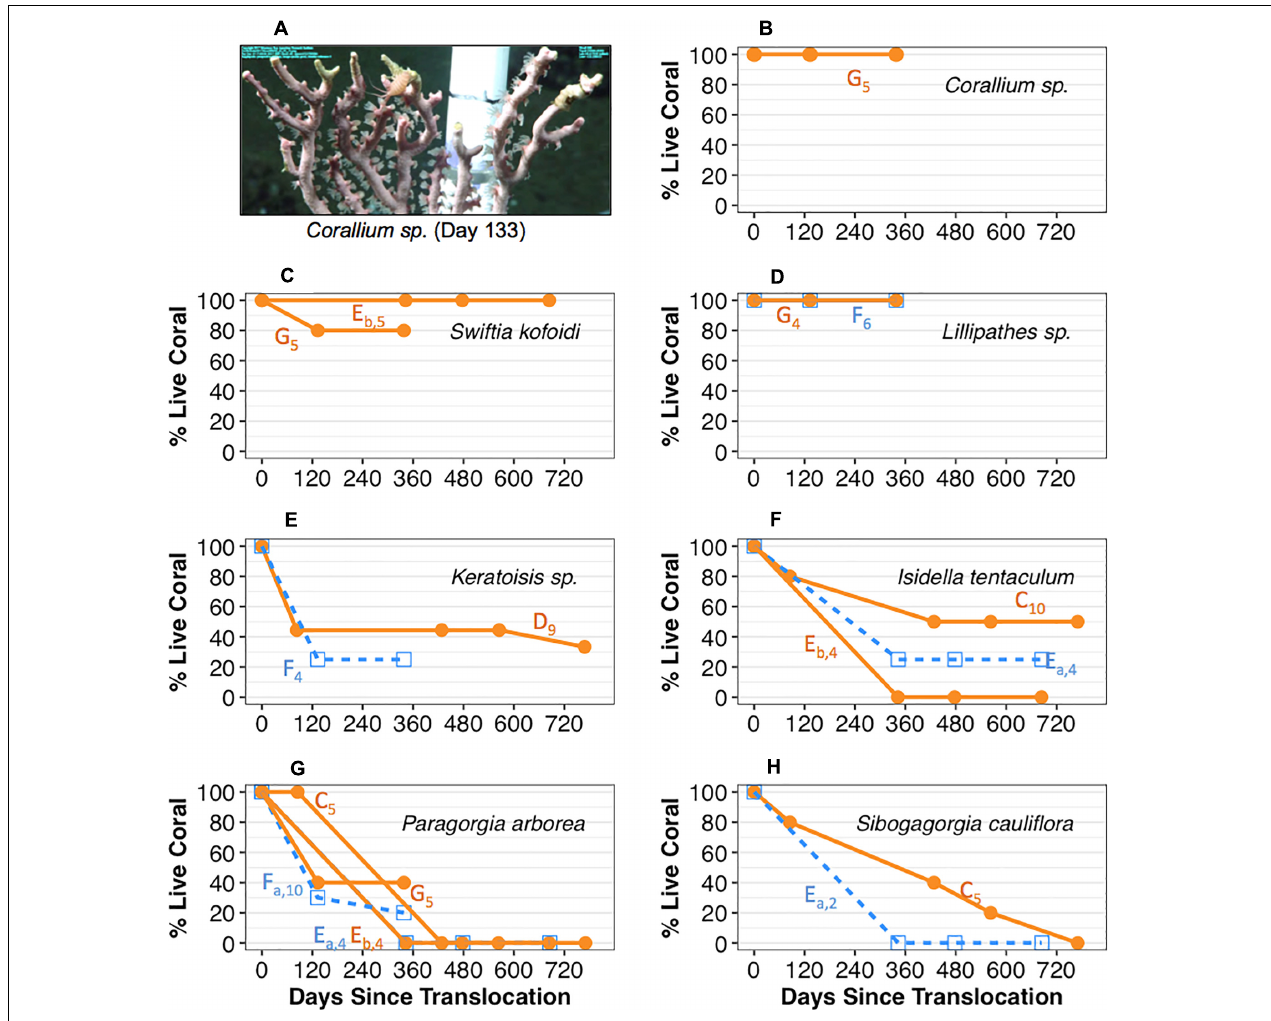
FIGURE 3 | Survivorship by coral species and transport treatment (Sur Ridge, California). (A) An example image of Corallium sp. fragment with conspicuous polyp extension at 133 days post-translocation. (B) Percent live Corallium sp. fragments over time. (C) Percent live Swiftia kofoidi fragments over time. (D) Percent live Lillipathes sp. fragments over time. (E) Percent live Keratoisis sp. fragments over time. (F) Percent live Isidella tentaculum fragments over time. (G) Percent live Paragorgia arborea fragments over time. (H) Percent live Sibogagorgia cauliflora fragments over time. For panels (B–H) , 0 days = the initial time when coral pots were translocated at depth. Open blue square data represent percent live of coral fragments that were exposed to overnight transport in shipboard aquaria; solid orange circle data represent survivorship for fragments that were translocated on the same day of collection. Coral group data by deployment are indicated by the letters next to each line along with the initial number of fragments at each deployment in subscript. All data represent results from deployment using the cement attachment method (coral pot